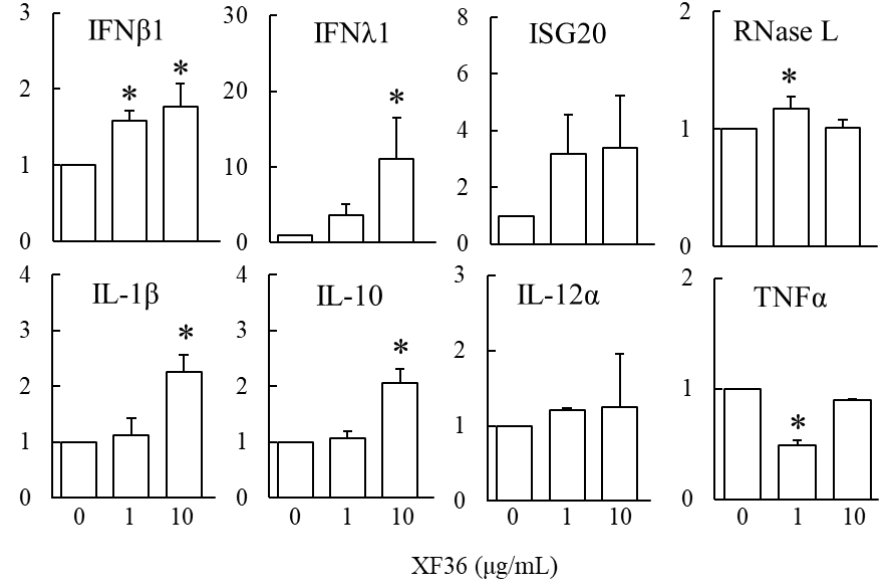
Figure 6. Effects of B. subtilis natto XF36 strain on the gene expression of interferons, interferon- stimulated genes, and cytokines in the cell culture model mimicking single-stranded RNA viral in- fection. M1-phenotype macrophages were cultivated with 1 µg/mL resiquimod (RSQ) and XF36 (0 – 10 µg/mL) for 3 h. Quantitative real-time reverse transcription polymerase chain reaction assessed the relative expression values. The data are presented as the mean and SD ( n = 3). The comparison among multiple groups was evaluated using Dunnett’s posttest following ANOVA. * p < 0.05 (vs. 0 µg/mL XF36).